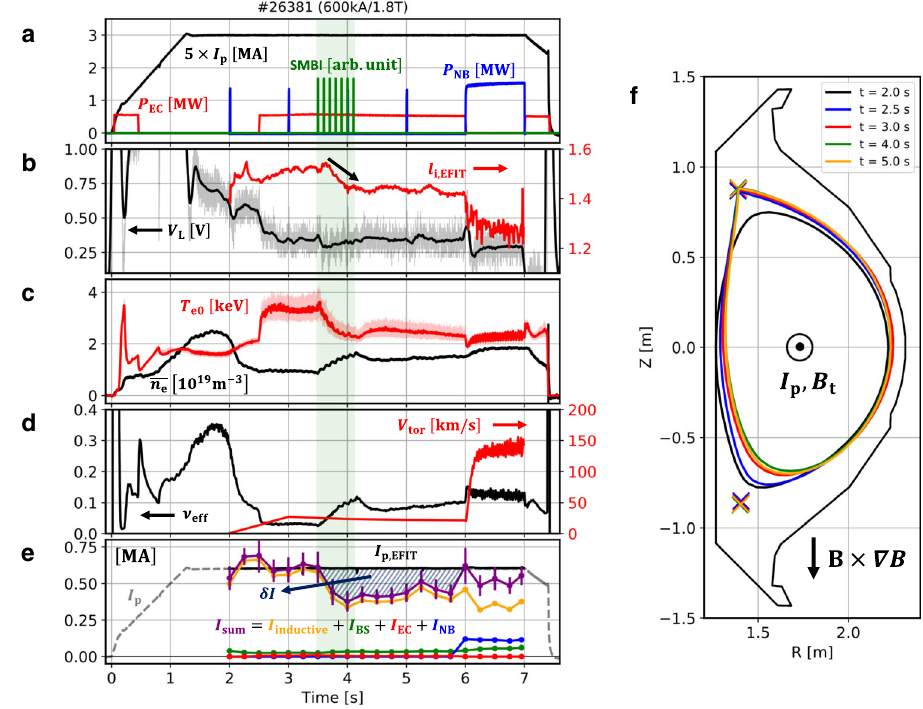
Fig. 1|Overview ofmainparametersofshot#26381in KSTAR.a Plasmacurrent ( I p ), neutral beam injection ( P NB ) and electron cyclotron ( P EC ) heating power, and supersonic molecular beam injection (SMBI). b Loop voltage ( V L ) and internal inductance ( l i ) from EFIT. c Central electron temperature ( T e0 ) and line-averaged density ( (cid:1) n e ). d Effective collisionality ( ν eff ) and central toroidal rotation velocity of the carbon impurity ( V tor ). e Components of the plasma current by